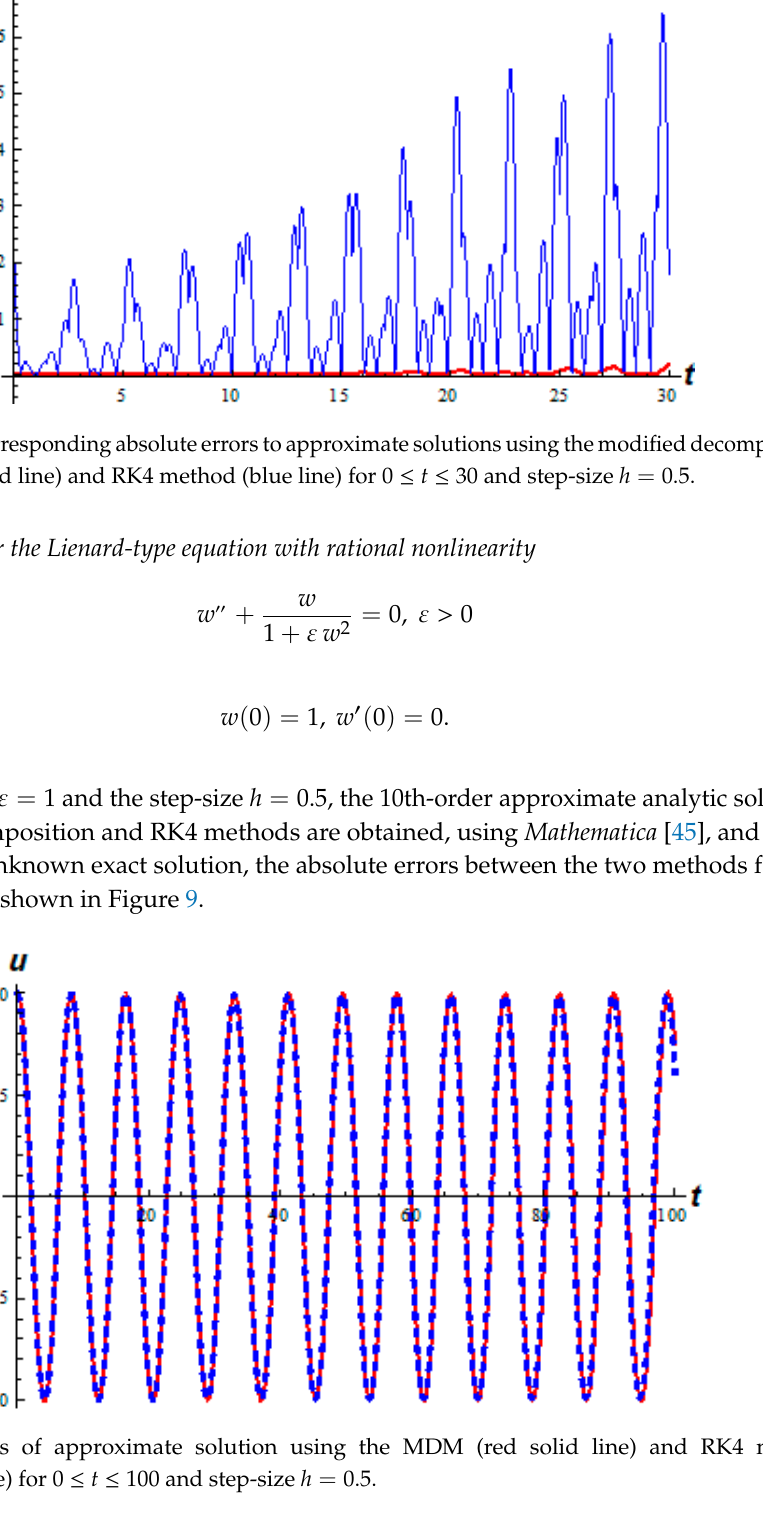
( ) W t (see Equation (15) using the modified decomposition n